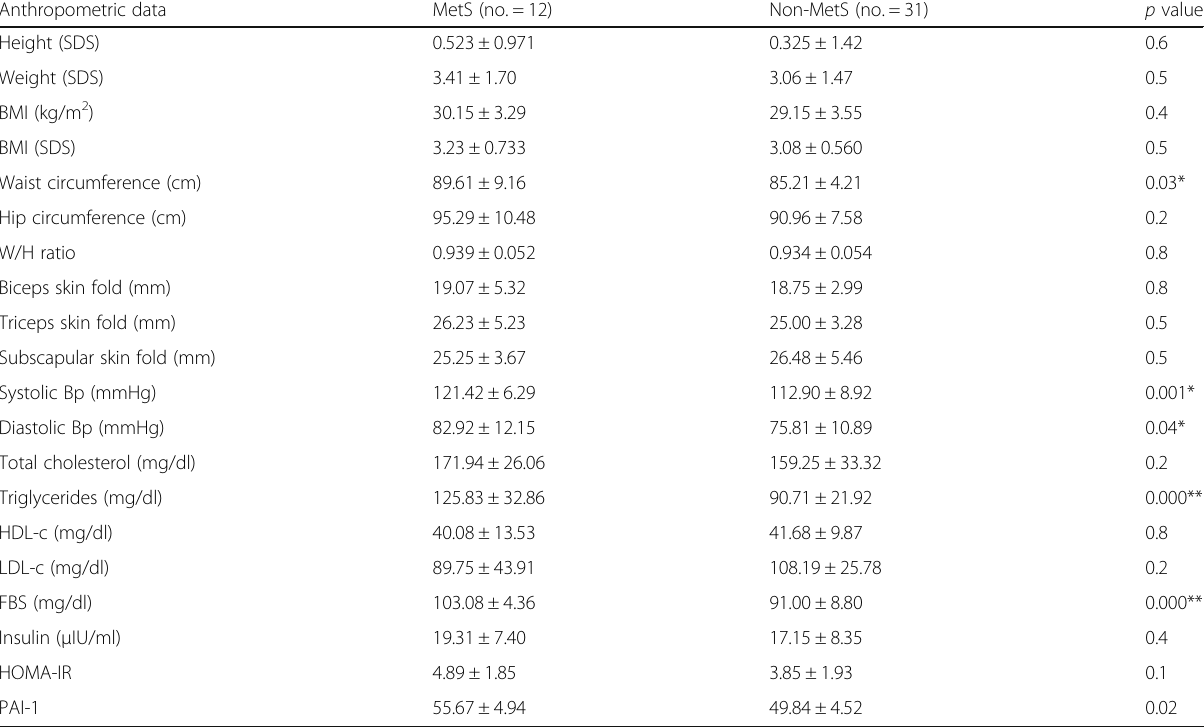
Table 3 Comparison between anthropometric and laboratory data in MetS and non-MetS obese patients Anthropometric